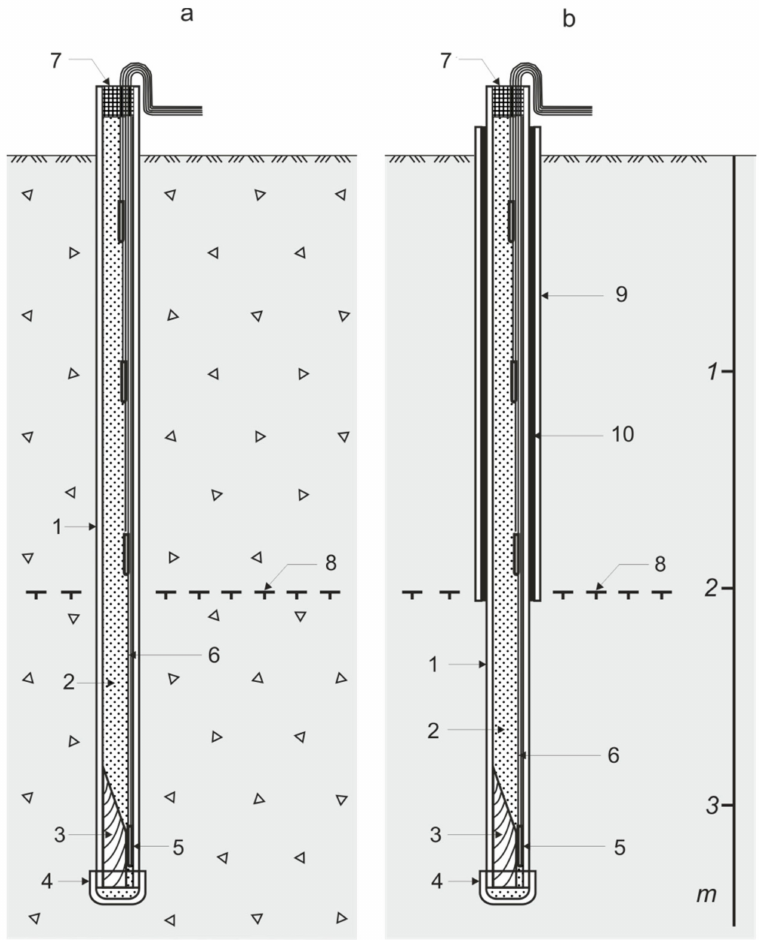
Figure 2. Design of a protective tubing case for datalogger sensors (( a )—for non-frost-susceptible soils, ( b )—for frost-susceptible soils). 1—polypropylene tube; 2—sand; 3—wooden edge; 4—closure; 5—temperature sensor; 6—cable; 7-sealant; 8—active-layer base; 9—heave-protection tube;